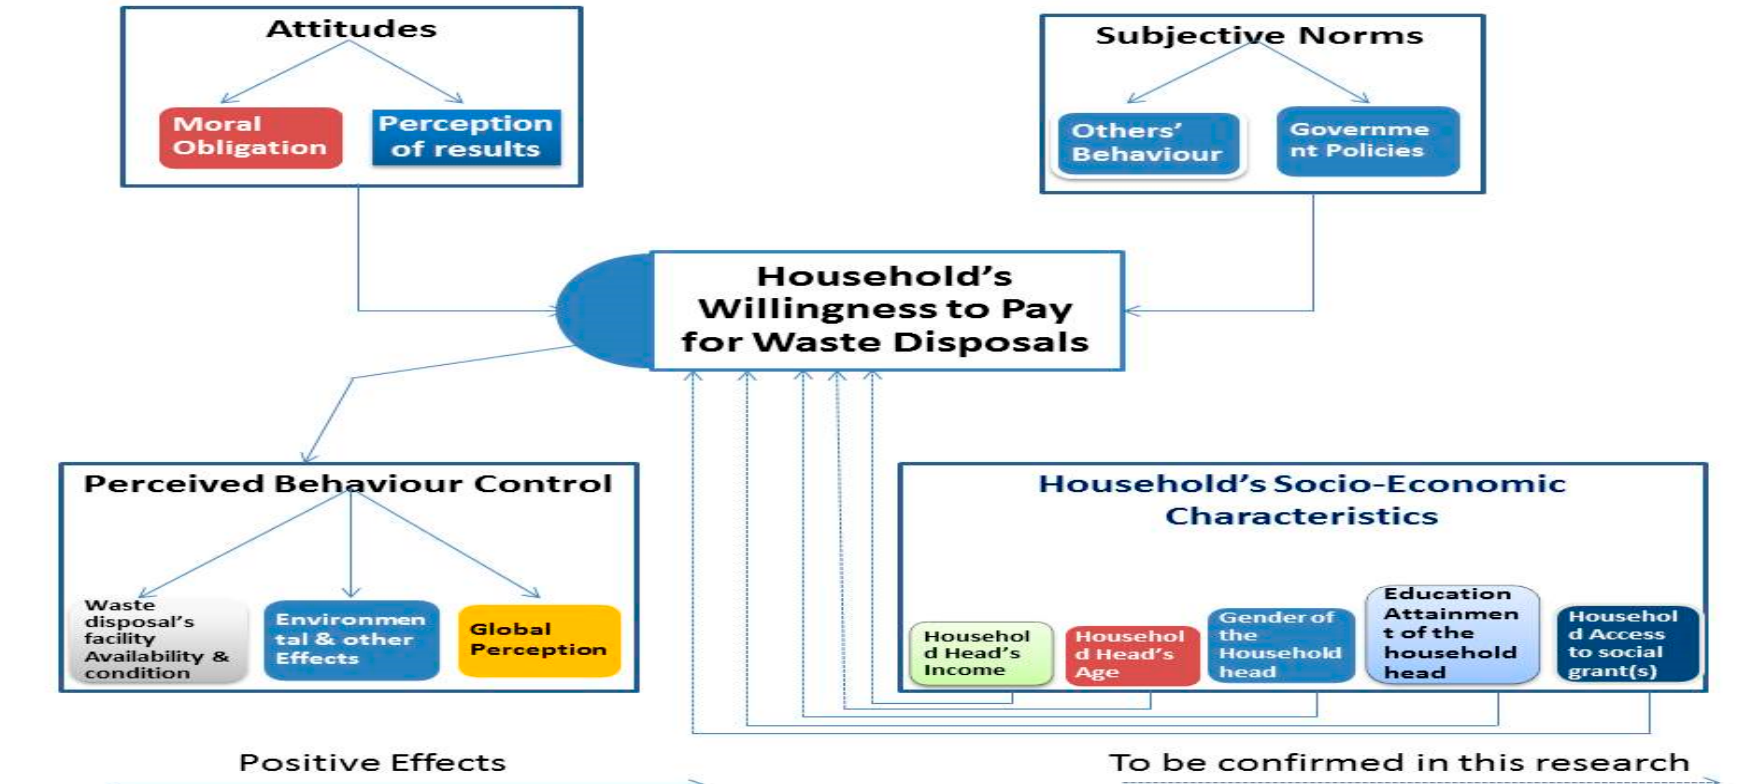
Figure 3. The hypothetical framework of the determinants of households’ recycling behaviour and payment for waste disposal.